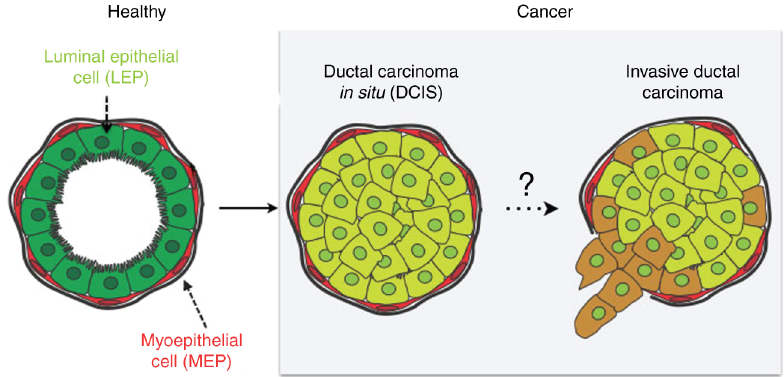
Figure 1: Natural history for breast adenocarcinoma ductal in situ (DCIS). It is observed the scheme of a mammary duct in histological cross section, and the transformation from a healthy histol- ogy to a pathological